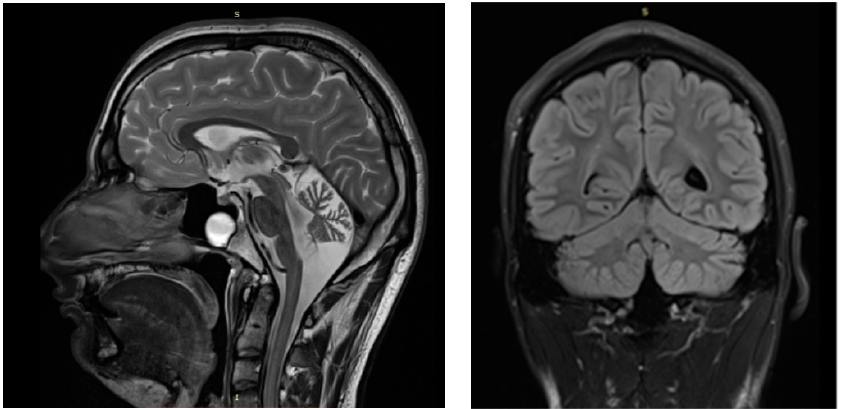
Figure 1. Brain MRI of the patient performed at 23 years. T1-weighted midsagittal section ( left ) and T2-weighted coronal ( right ).